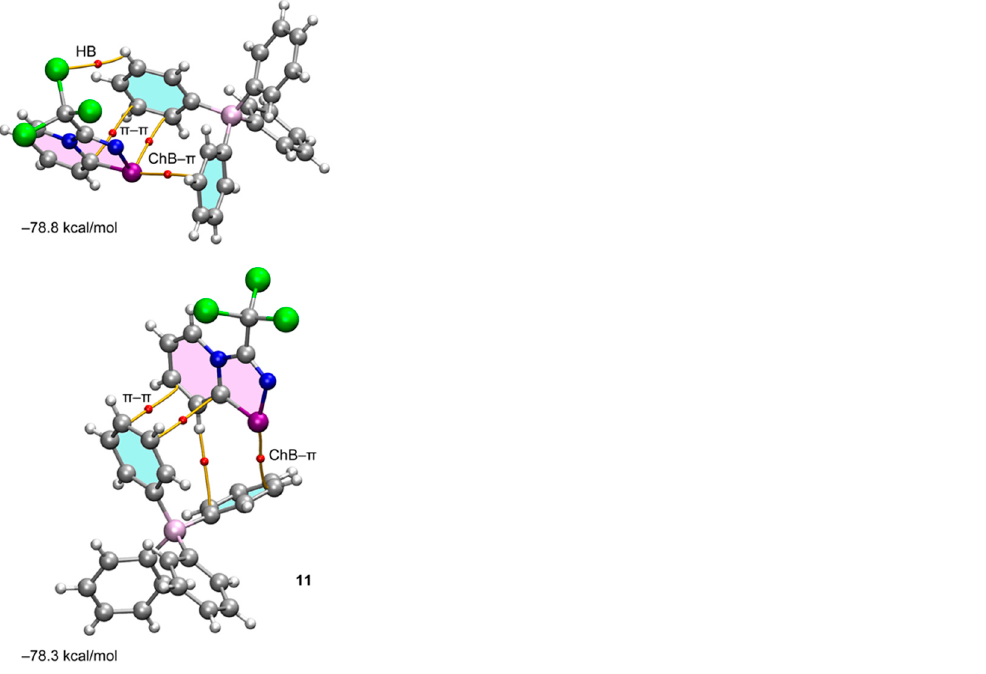
Figure 8. QTAIM analyses of two dimers of compound 11 . Only intermolecular bond CPs and bond paths are represented.